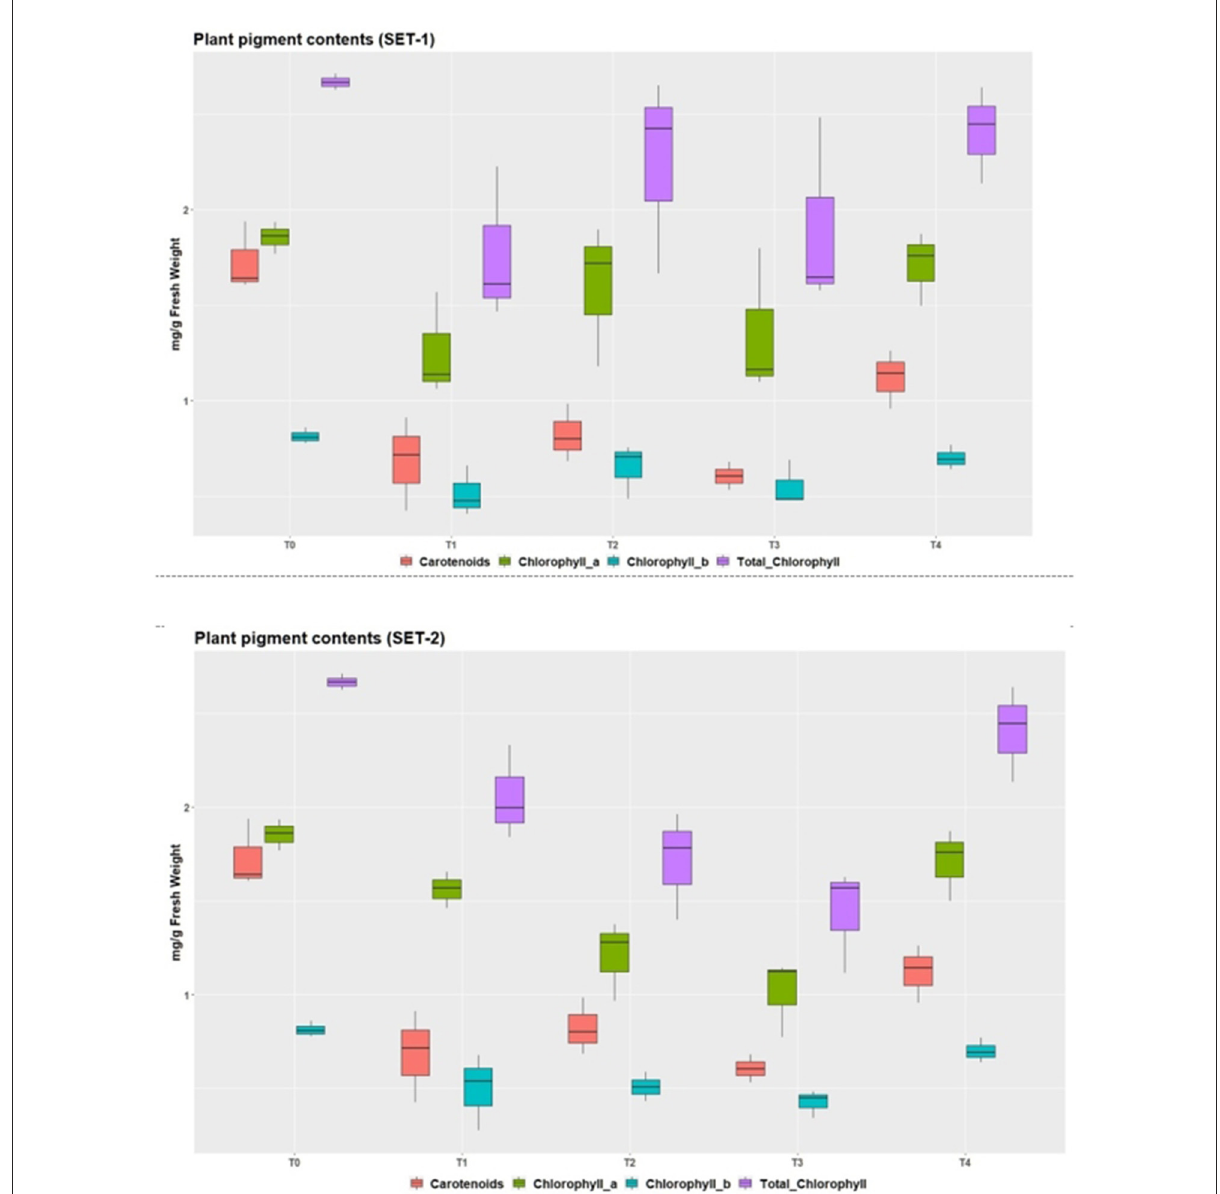
FIGURE6 Chlorophyll pigments in P. hysterophorus under the effect of various treatments in two sets.